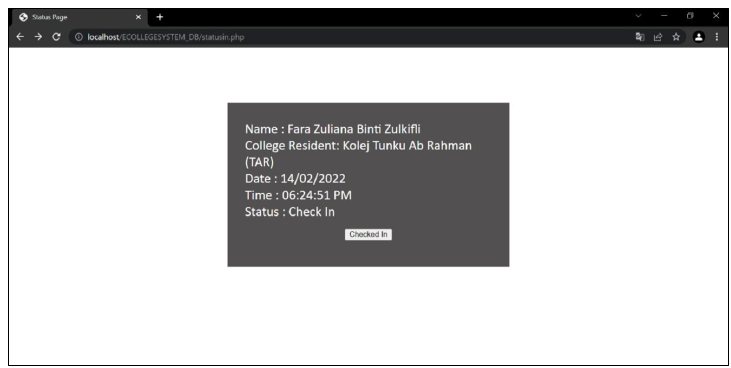
Figure 7. Status check-in page.